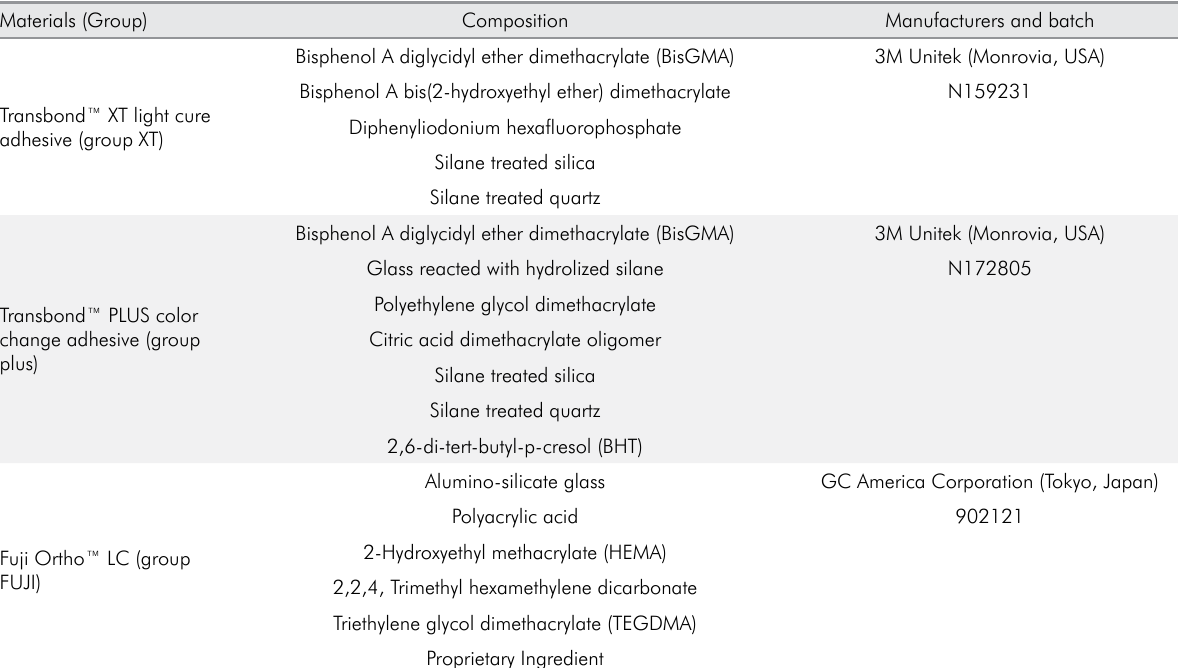
Table 1. Orthodontic bonding systems’ composition, manufacturer and sample distribution. Materials